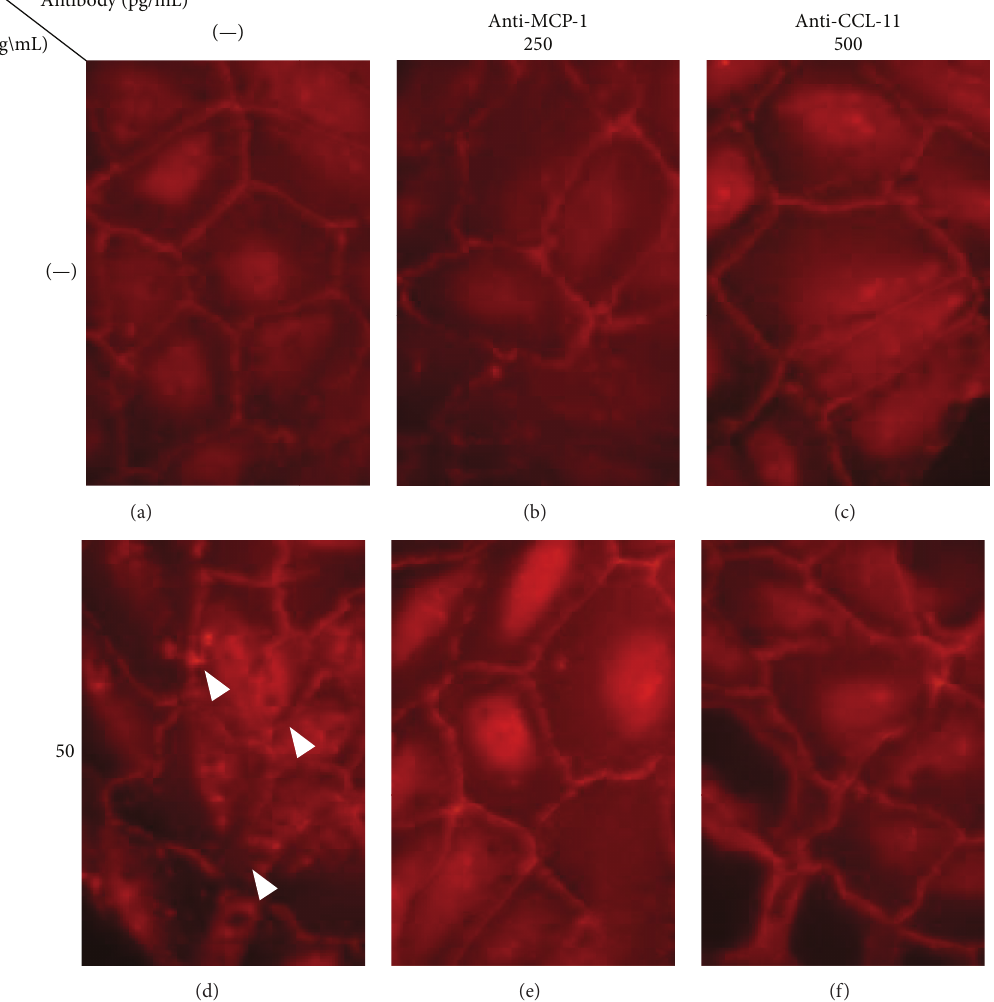
Figure 3: Hypoxia-induced tight junction disruptionis also suppressed by blockade of MCP-1or CCL-11.Exposureon ARPE-19cells to CoCl 2 causes TJ disruption ((d) arrow head). When the cells were pretreated with anti-MCP-1 or CCL-11 antibody, these changes were reduced in the ZO-1 pattern compared to that of the control ((e), (f)). Thus, blockade of MCP-1 and CCL-11 can protect conformation of TJs from hypoxic stress. CCL-11, Chemokine (C-C Motif) Ligand 11; IL, interleukin; LBI, lecithin-bound iodine; MCP-1, monocyte chemoattractant protein-1; TJs, tight junctions; ZO-1, zonular